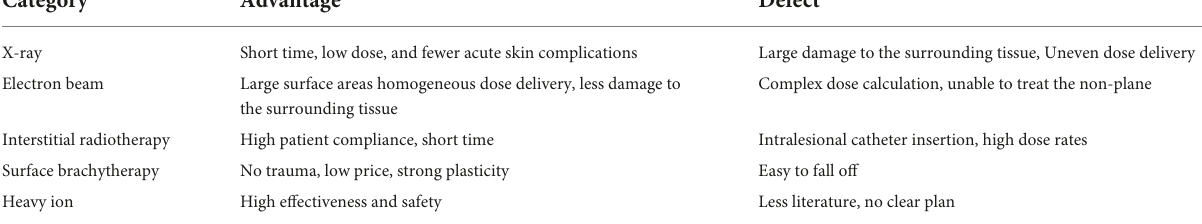
TABLE 4 Advantages and disadvantages of adjuvant radiation